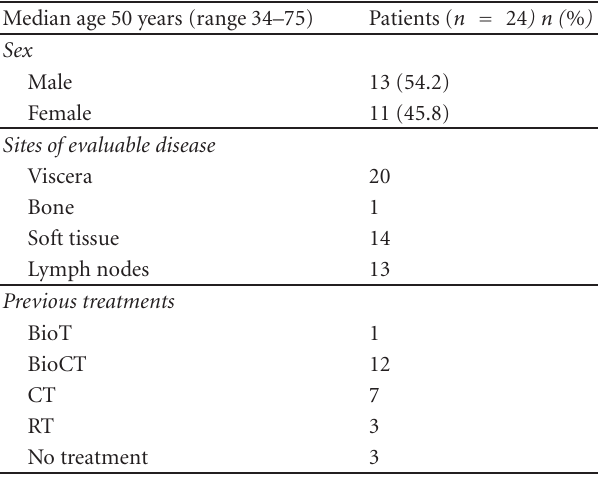
Table 2: Patient characteristics.